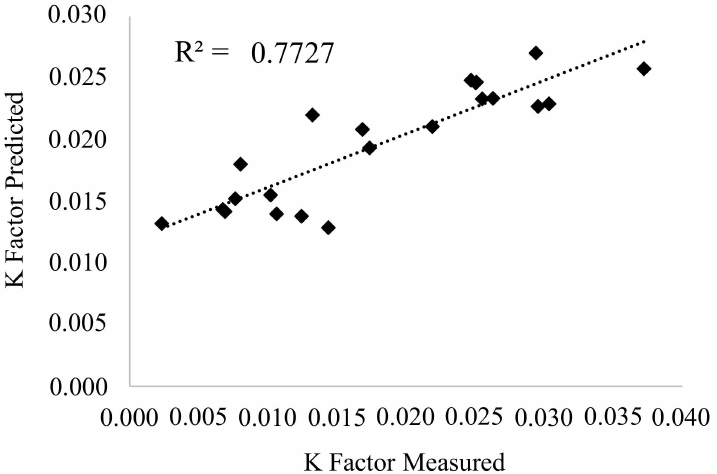
Figure 8. Comparison between the K-Factor satellite-based predicted and K-Factor measured by the soil samples